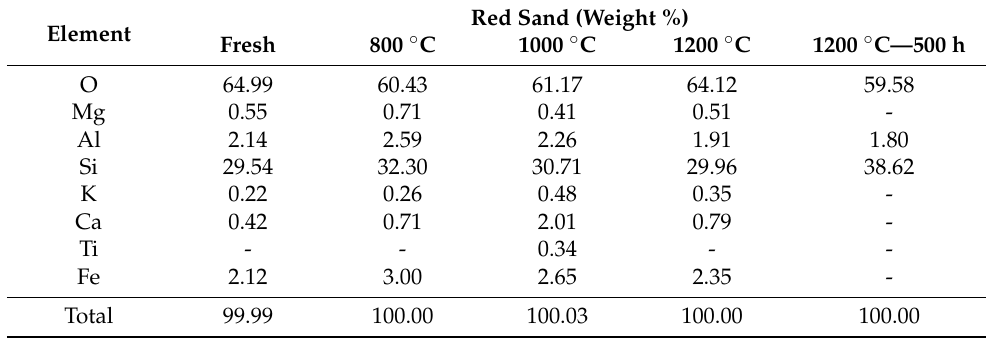
Table 5. Elemental composition of red